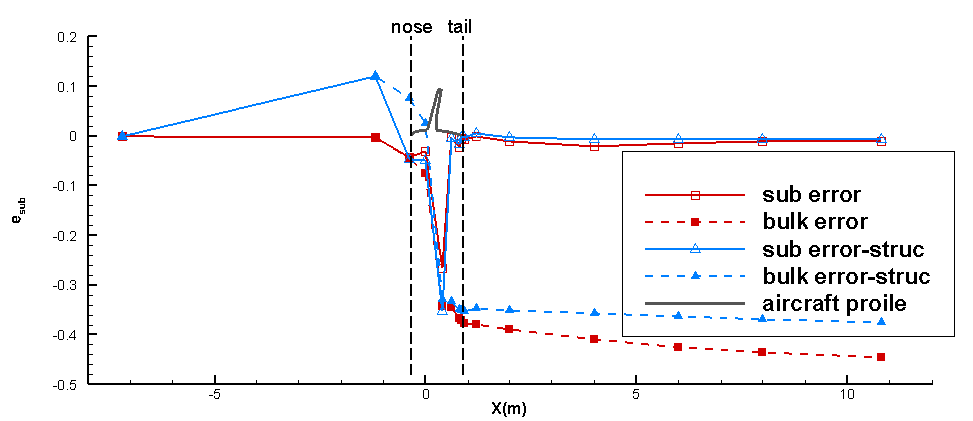
Figure 11. Subdomain error study for unstructured mesh (red lines) and multiblock structured mesh (blue lines). Table 6. Power imbalance error for unstructured mesh and multiblock structured mesh.